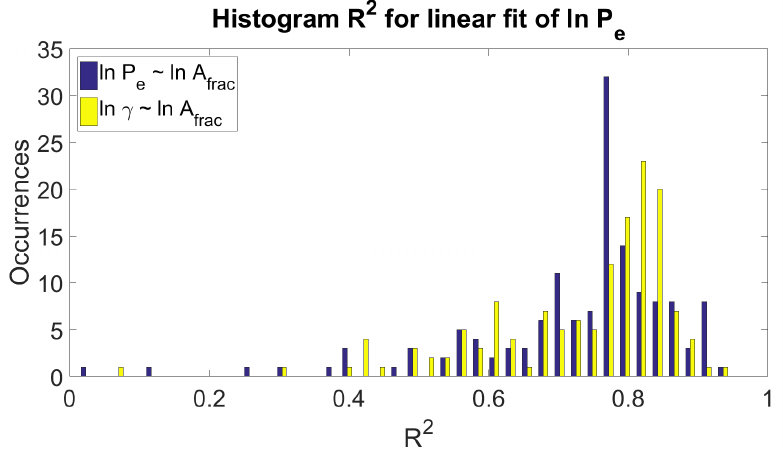
Figure 9. Histogram of the coefficient of determination R 2 for the linear regression of lnP e ∼ lnA frac as well as ln γ el ∼ lnA frac